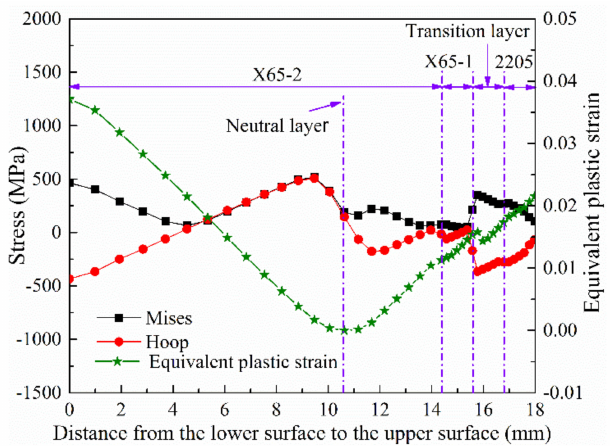
Figure 21. Stress and PEEQ distribution in the plate thickness direction after